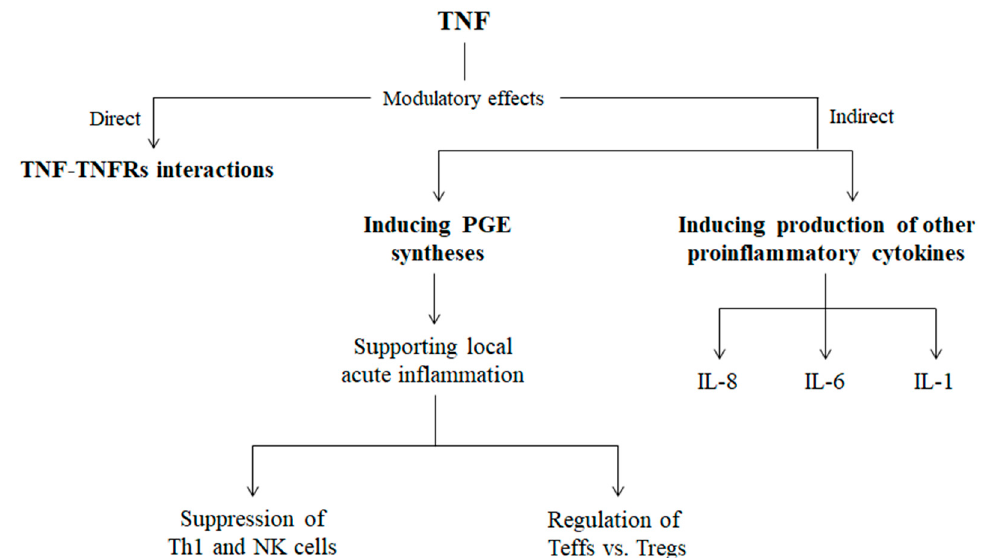
Figure 3. The modulatory effects of TNF on pain and tissue degradation in TMDs. Elevated TNF levels are considered pathological and positively correlated with the inflammatory response and pain in TMDs. The modulatory effects of TNF are divided to direct and indirect effects. The direct effect is based on the interaction of TNF with TNFR1 and TNFR2 as explained in the previous section, while the indirect effect is divided to two main pathways; through inducing production of other proinflammatory cytokines (IL-1, IL-6 and IL-8, mainly) and prostaglandin (PGE) synthesis. PGE in turn plays a vital role in supporting local acute inflammation by regulation of effector T cells (Teffs) vs. regulatory T cells (Tregs), and also by suppression of the T helper 1 (Th1) cells and natural killer (NK) cells [115,117,118].